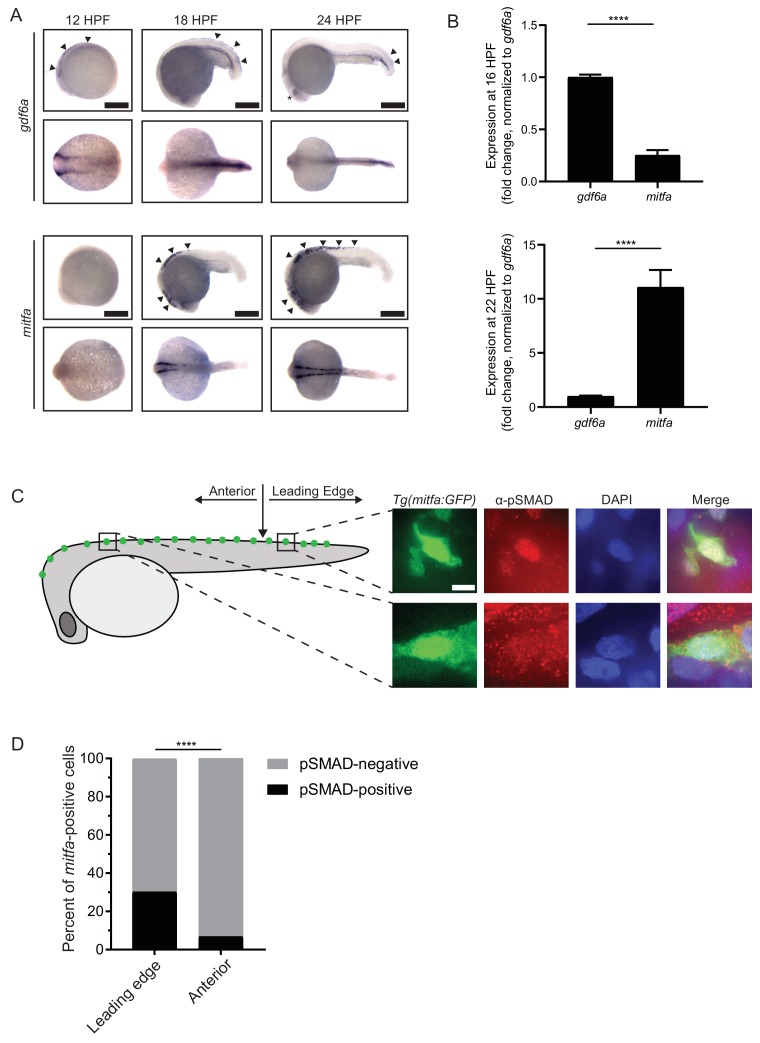
gdf6a expression and BMP activity in pigment progenitor cells.(A) RNA in situ hybridization for gdf6a (top) and mitfa (bottom) at 12-, 18-, and 24 hr post-fertilization. Arrowheads indicate expression domains in the region of the neural crest of gdf6a and mitfa. Asterisk indicates known dorsal retinal expression of gdf6a. Scale bar = 500 µm. (B) Expression of gdf6a and mitfa from neural crest cells isolated from Tg(crestin:eGFP) embryos by FACS at 16 HPF and 22 HPF. Samples were normalized to gdf6a expression. n = 5–6 replicates per conditions from two independent experiments (N = 2). (C) Images of GFP-positive cells from Tg(mitfa:eGFP) zebrafish stained with α-pSMAD 1/5/8 antibody. Scale bar = 10 µm. (D) Quantification of mitfa:eGFP-positive cells that are phospho-SMAD1/5/8-positive. The leading edge encompassed the five most posterior mitfa-positive cells, whereas anterior cells constituted any mitfa-positive cells anterior to the leading edge. n = 102 and 186 for distal leading edge and anterior cells, respectively, from three independent experiments (N = 3). P-values were calculated using Fisher’s exact test for panels B and D, ****p<0.0001.Figure 3—source data 1.gdf6a expression and BMP activity in pigment progenitor cells.